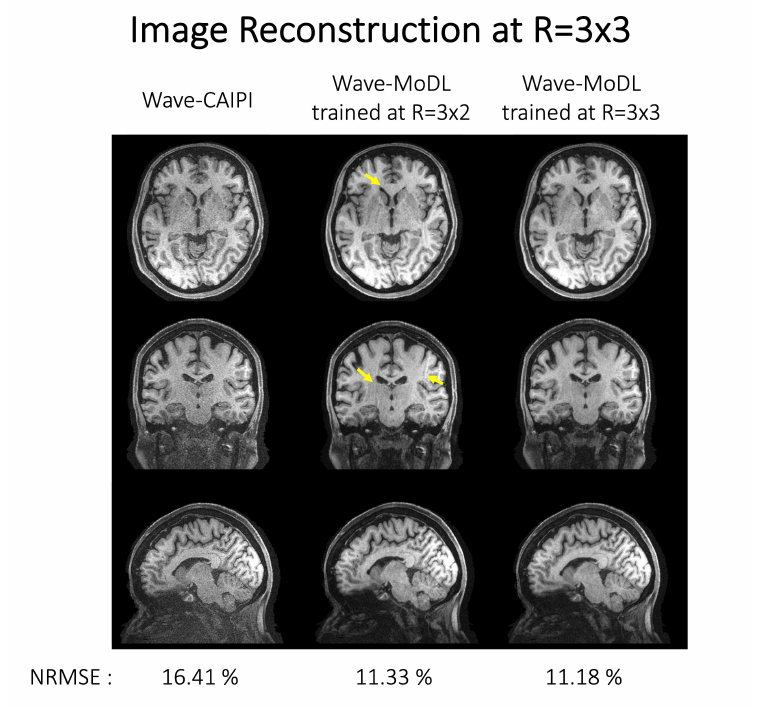
Figure 9. Image reconstruction on HCP database subsampled at R = 3 × 3 using ( left ) wave-CAIPI, ( middle ) wave-MoDL trained at R = 3 × 2, and ( right ) wave-MoDL trained at R = 3 × 3. NRMSEs were calculated for the entire testing database. The network would not be generalized and required to be fine-tuned at a different reduction factor or sampling